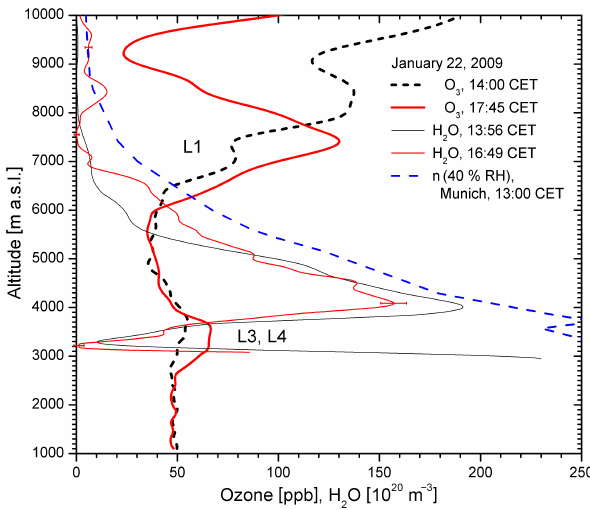
Figure 12. Two selected water-vapour density profiles from the Fig. 12. Two selected water-vapour density profiles from the single-day time series, that ended single-day time series that ended shortly before 21:00CET. The cor- shortly before 21:00 CET. The corresponding ozone profiles are given for comparison. The labels responding ozone profiles are given for comparison. The labels L1, L1, L3 and L4 correspond to those in Fig. 11. The dryness of the intrusion layers layers is further L3 and L4 correspond to those in Fig. 11. The dryness of the in- visualized by adding the number density corresponding to 40 % relative humidity, calculated from trusion layers is further visualized by adding the number density the Munich 13:00-CET.temperature profile. corresponding to 40% RH, calculated from the Munich 13:00CET temperature